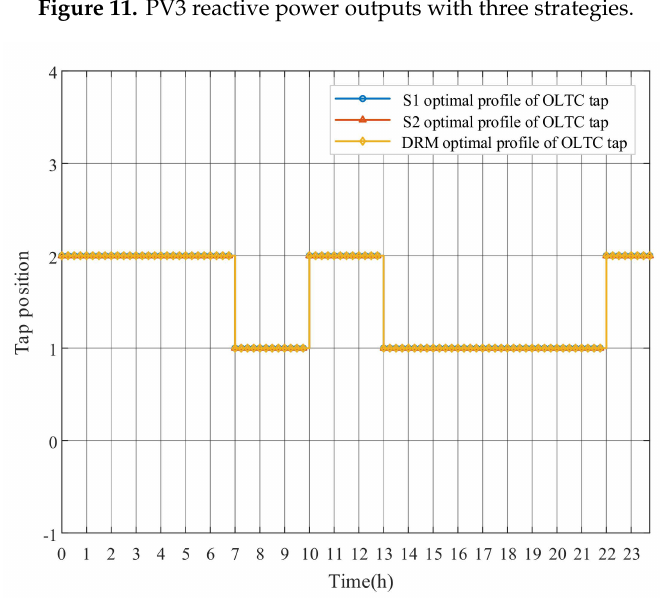
Figure 11. PV3 reactive power outputs with three strategies.